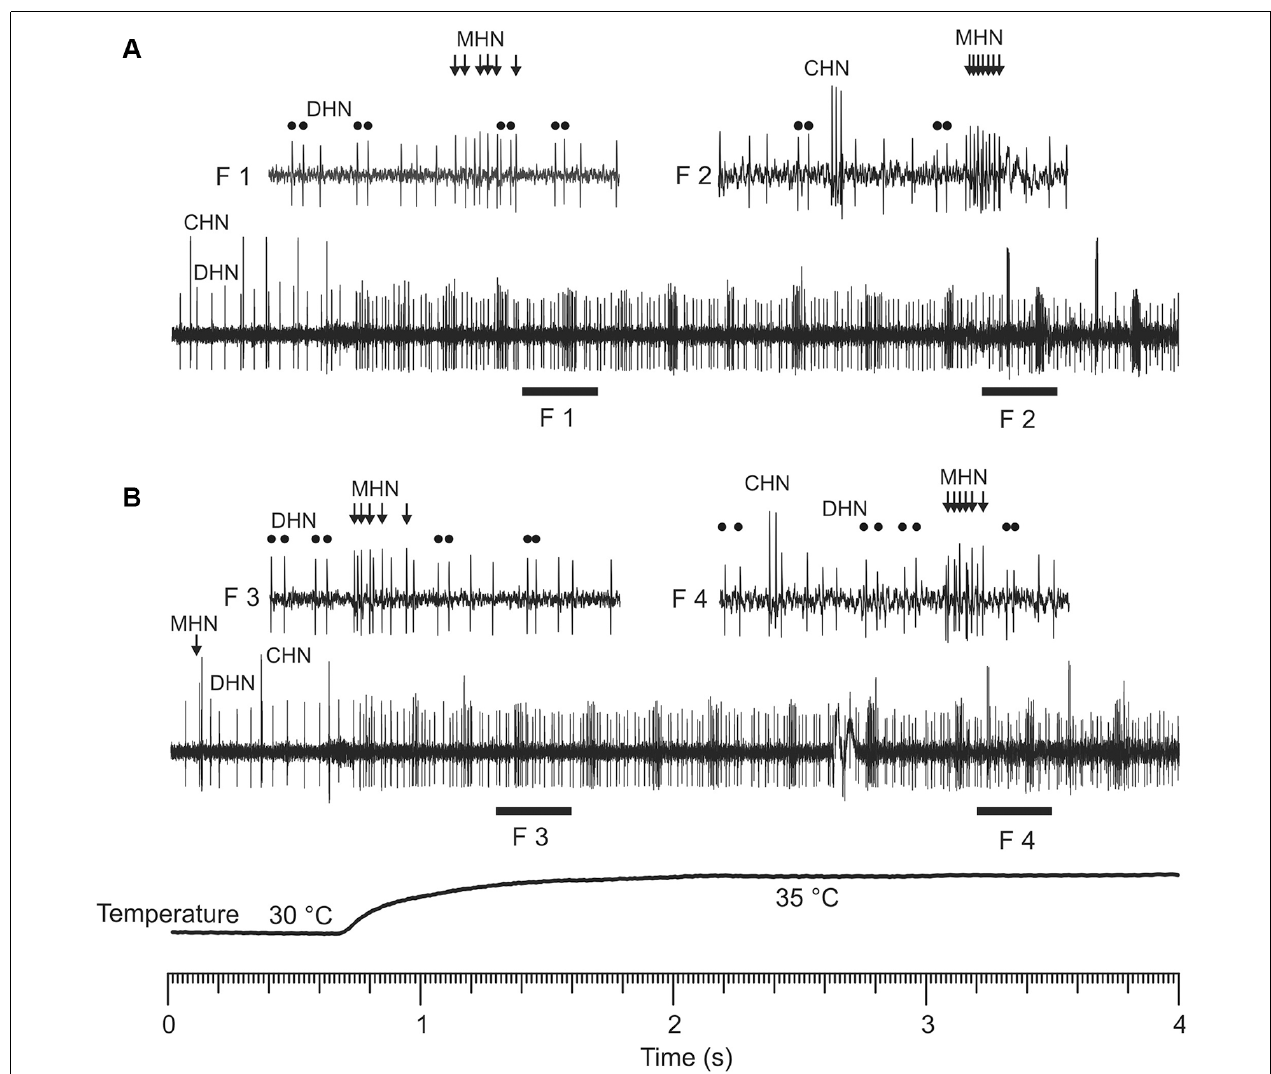
FIGURE 3 | Repeatability of spike burst responses of the DSS neurons in a rapid warming experiment. Note that a particular DSS neuron produced nearly identical bursty spike trains (A,B) in response to the same consecutive warming stimulus. Temporal interval between the two stimulations was 10 min. F1–F4 show fragments of the original recordings (A,B) in a shorter timescale. High-frequency spike bursts of the CHN were shown in the fragments F2 of (A) and F4 of (B) , respectively. Double round dots demonstrate bursty spikes of the DHN in the fragments F1–F4, respectively. Bunches of arrows in the fragments F1–F4 indicate bursty spikes generated by the